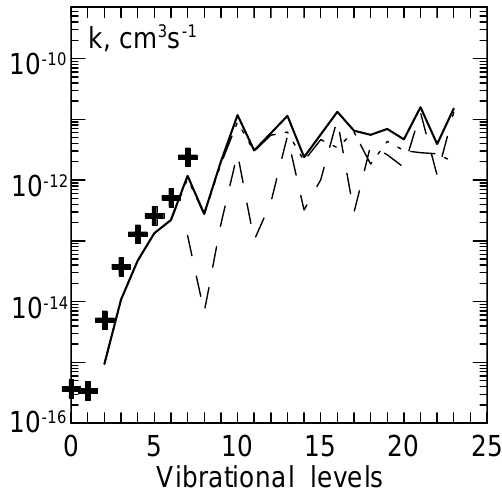
Fig. 4. The calculated quenching rate coefficients of O 2 (A 3 6 + u , Fig. 6. The calculated quenching rate coefficients of N 2 (A 3 6 + u , v =0-10)+N 2 (solid line) are compared with experimental data by v =2–23)+N 2 (solid line) are compared with experimental data by Fig.4. Knutsen et al. (1994) (triangles). Dreyer and Perner (1973) (crosses). Dashed line and dash and three dotted line are the contributions of intramolecular and intermolecu- lar electron energy transfer processes,